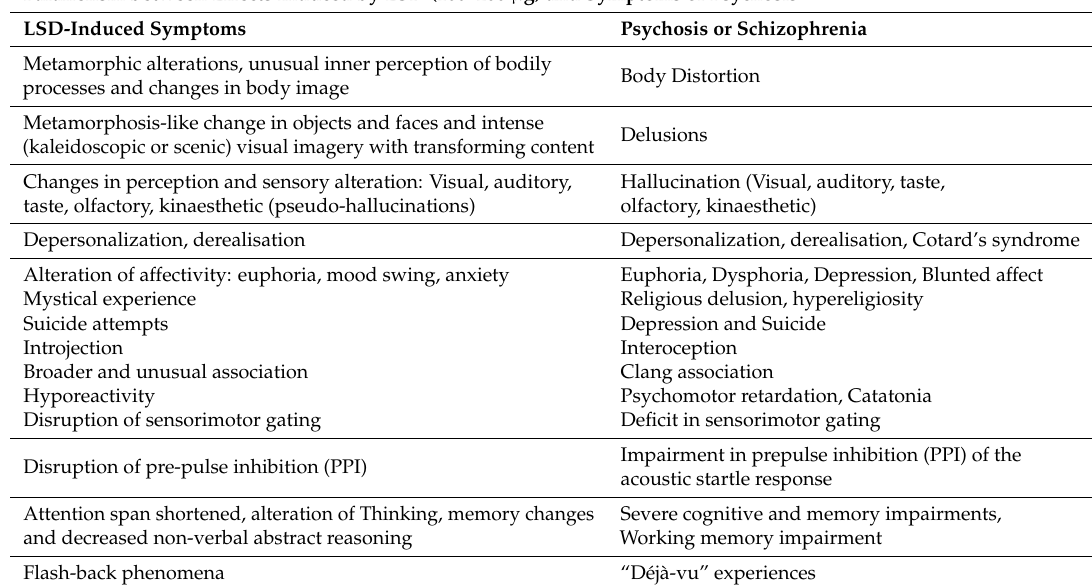
Table 1. List of the most relevant effects induced by LSD related to a psychotic-like syndrome (left) and symptoms of psychosis (right). (Modified after: Passie et al., 2008 [5] and Schmid et al., 2015 [9]). Parallelism between Effects Induced by LSD (100–200 µ g) and Symptoms of